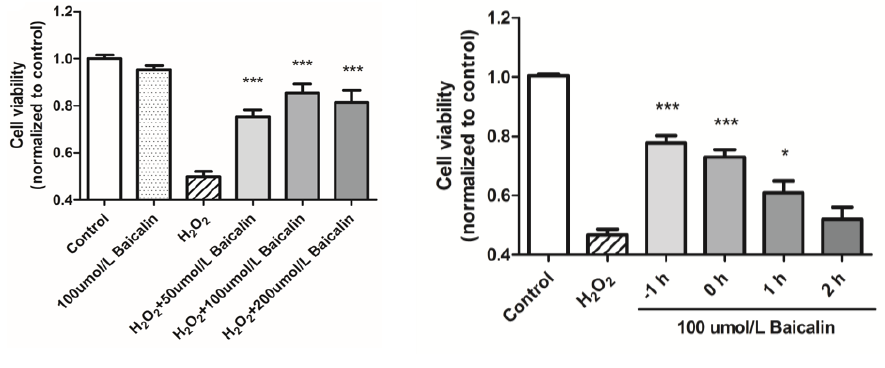
Figure 1. Effects of Baicalin on the cell viability in HK-2 cells by the CCK-8 assay. HK-2 cells were treated with H O and Baicalin together or separately. The effects of Baicalin 2 2 treatment were evaluated under different concentrations ( A ) and start times